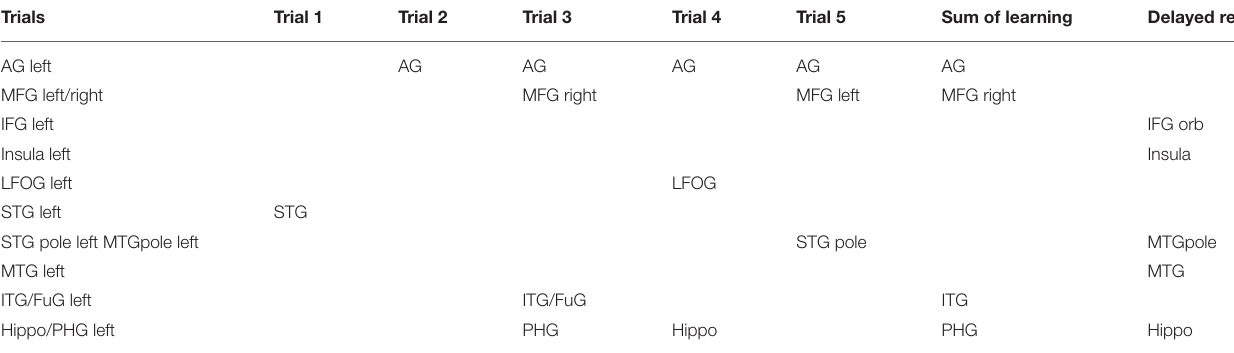
TABLE 10 | Summary table for all regression